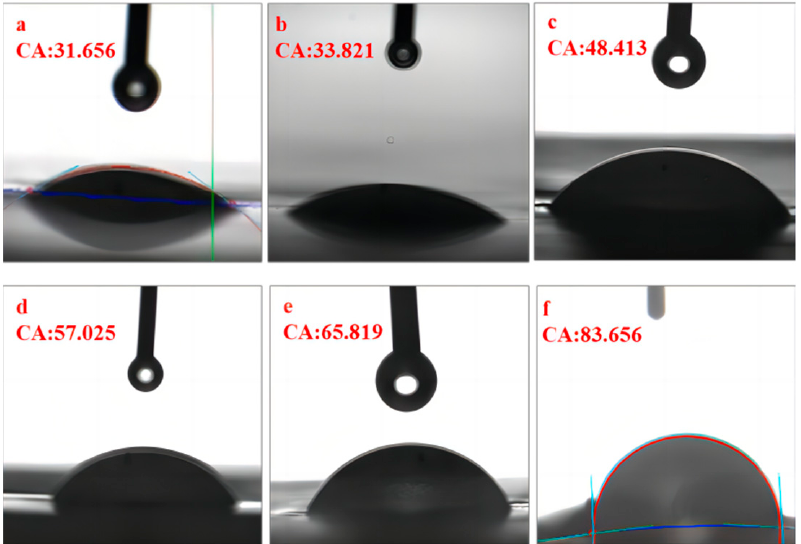
Figure 5. OCA analysis of six different CFGO-PVDF ultrafiltration membranes. ( a – e ) Composite UF membrane with minimum to maximum contact angle; ( f ) PVDFUF membrane without CFGO.